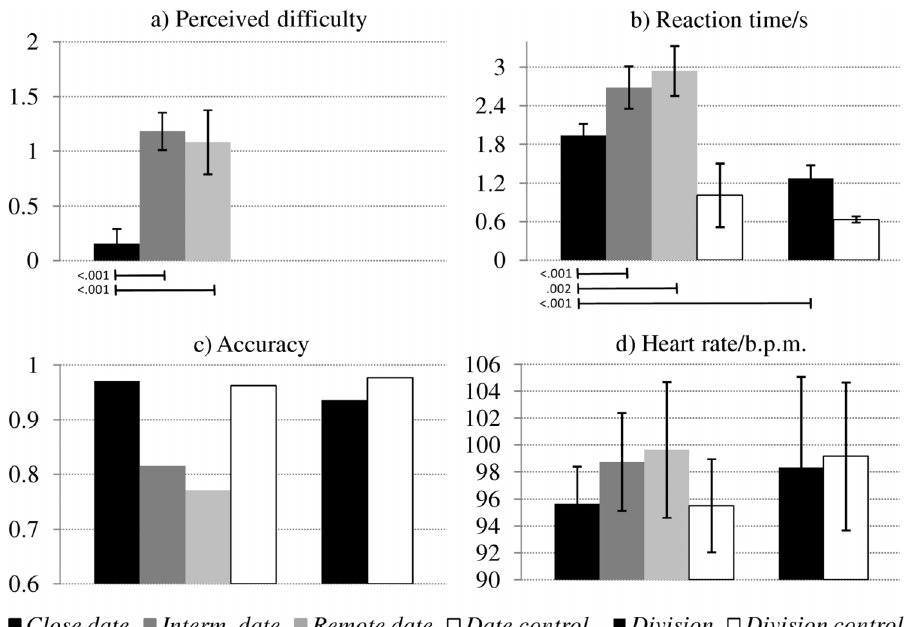
Figure 2. Behavioural and physiological responses for the different tasks and difficulty levels. ( a ) Perceived difficulty of calendric trials based on YV’s ratings after the scan (scale 0–2, where 0 is easy, 1: challenging, 2: very difficult). ( b ) Reaction times in seconds. First 3 bars correspond to calendric task, 4 th bar to the calendric control task, 5 th to division task and 6 th to division control task. ( c ) Response accuracy for close dates: 97%, for intermediate dates: 82%, for remote dates: 77%, for the control task: 96%. Response accuracy for the division task was comparable to the performance for close dates at 94%, while accuracy for the control division condition was at 98%. ( d ) Heart rate in beats per minute (b.p.m.). Blocks containing close dates were perceived as significantly less challenging that those presenting intermediate or remote dates, and elicited shorter reaction times. Heart rate closely followed this pattern, but differences did not reach statistical significance. Error bars denote 1 standard deviation across blocks. Significance values are Bonferroni corrected over condition